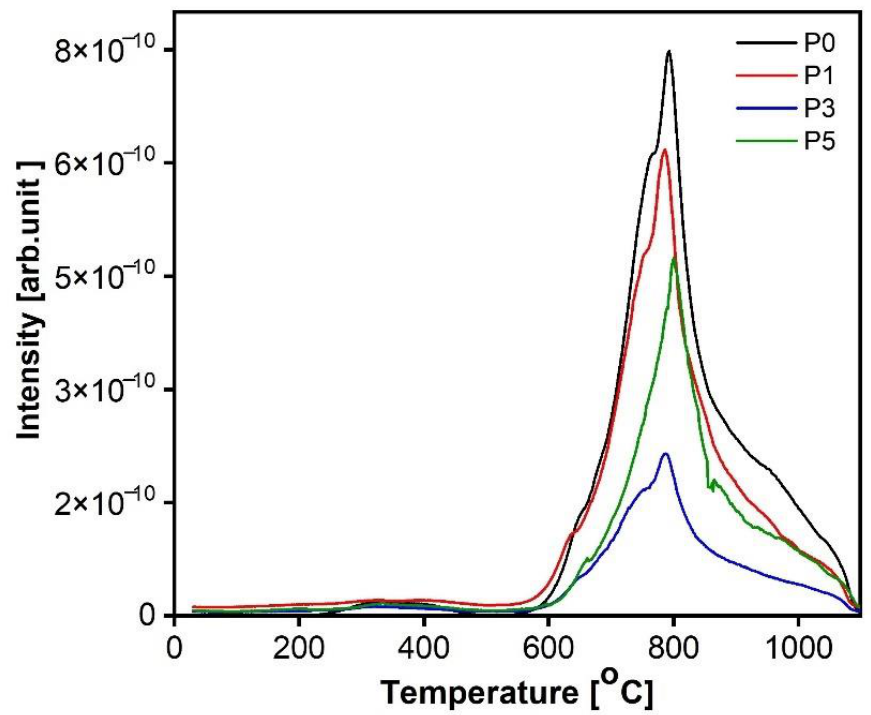
Figure 10. Plots of MS signal of carbon dioxide (m/z = 44) over time of paste samples after 28 days curing.